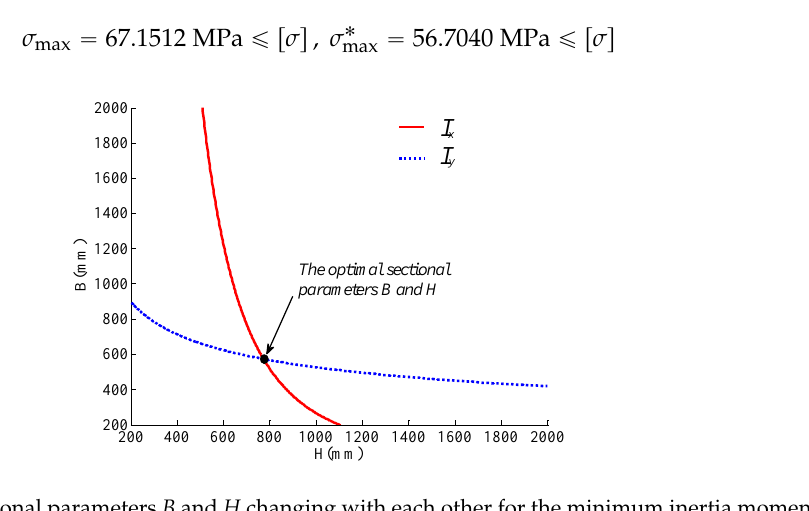
Table 3. The parameters of movable crossbeam of the hydraulic press.